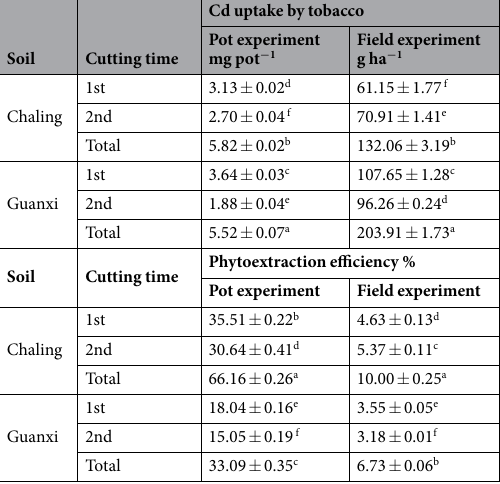
Table 3. Cd uptake and phytoextraction efficiency of tobacco grown in different soils after two cuts. Note: Standard deviation is represented as ± SE (n = 3); columns with different letters indicate a significant difference at the P ≤ 0.05 level on the basis of Duncan’s multiple range test.